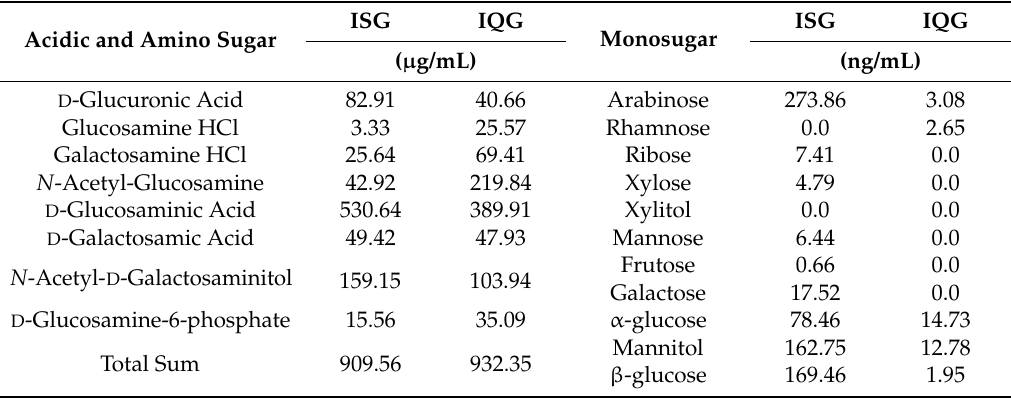
Table 7. Monosaccharide composition of purified ISG and